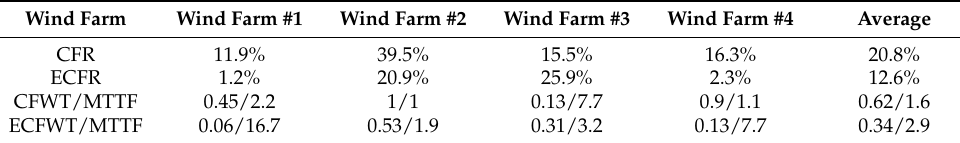
Table 5. The statistic of critical and extremely critical failures (per year).